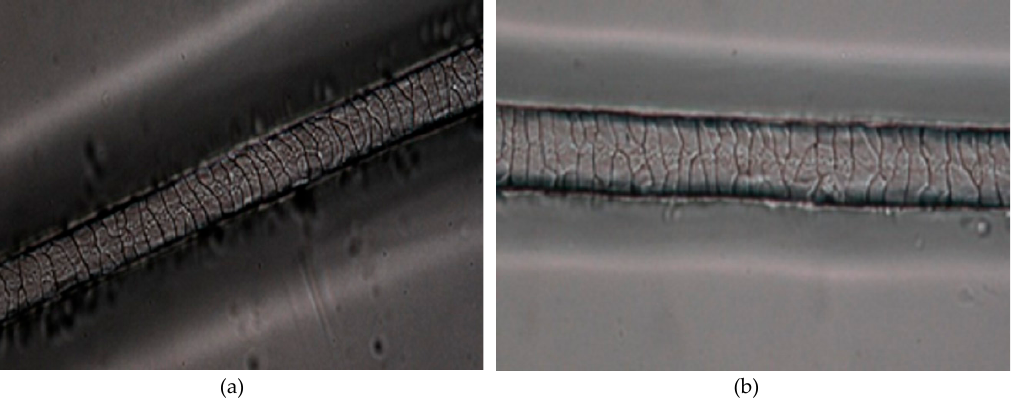
Figure 1. ( a ) A transverse wave cuticle pattern with smooth scales margins found on the hair shaft of the Brazilian local cattle Curraleiro Pé-Duro and Bovino Pantaneiro; ( b ) A irregular wave cuticle pattern with smooth scales margins found on the hair shaft of the Brazilian local cattle Caracu and zebu Nelore. Sections of the hair images were acquired digitally through an optical microscopy with 40.0× objectives.